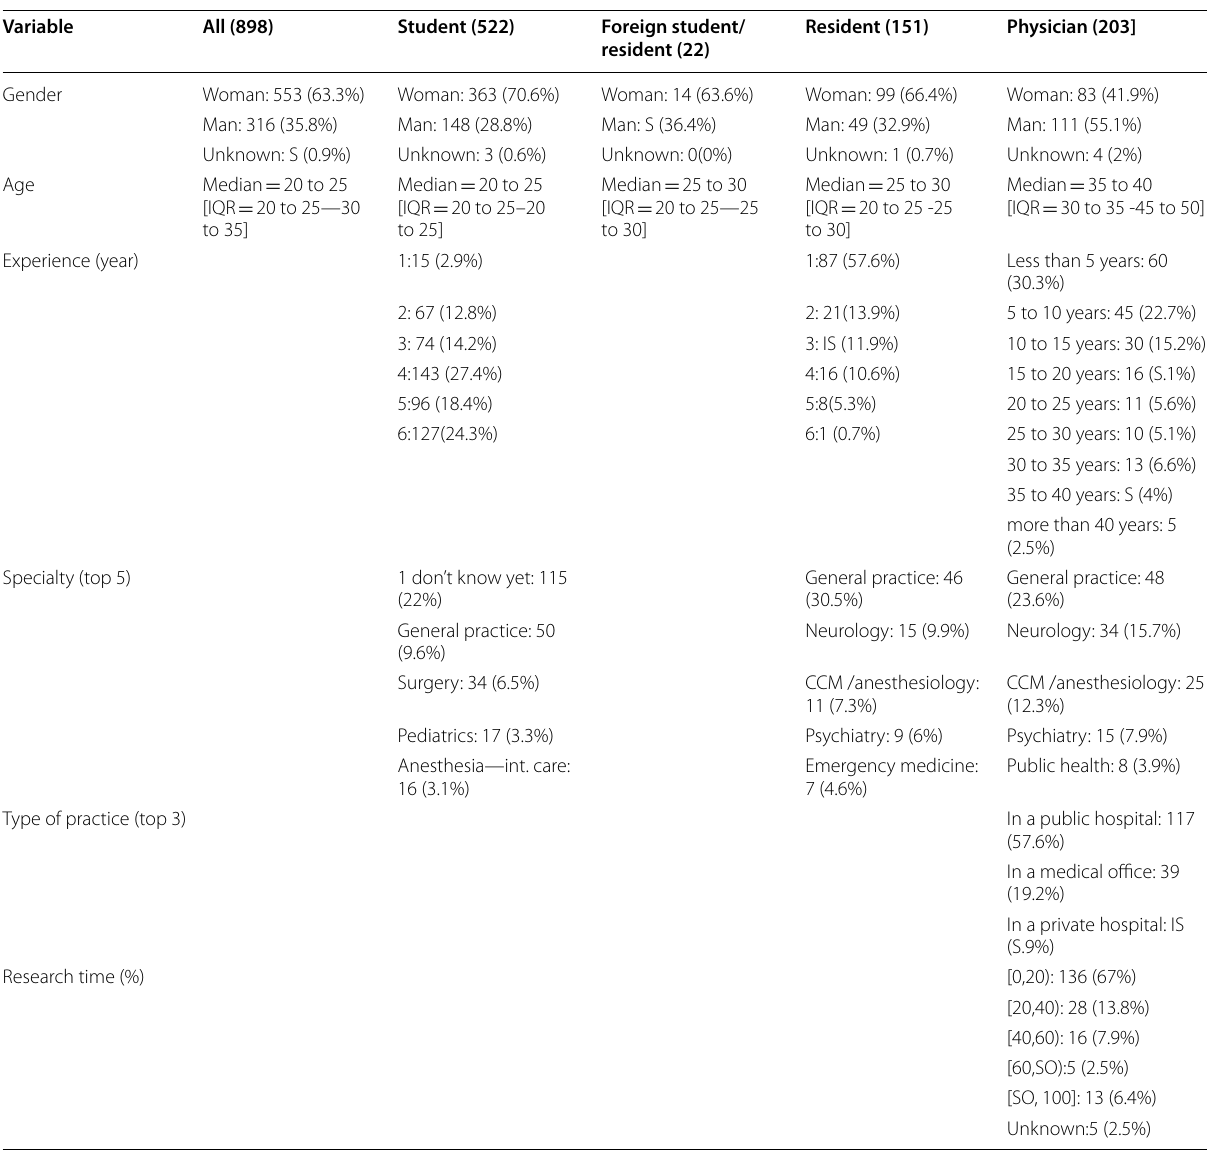
Table 1 Demographics from all participants (N